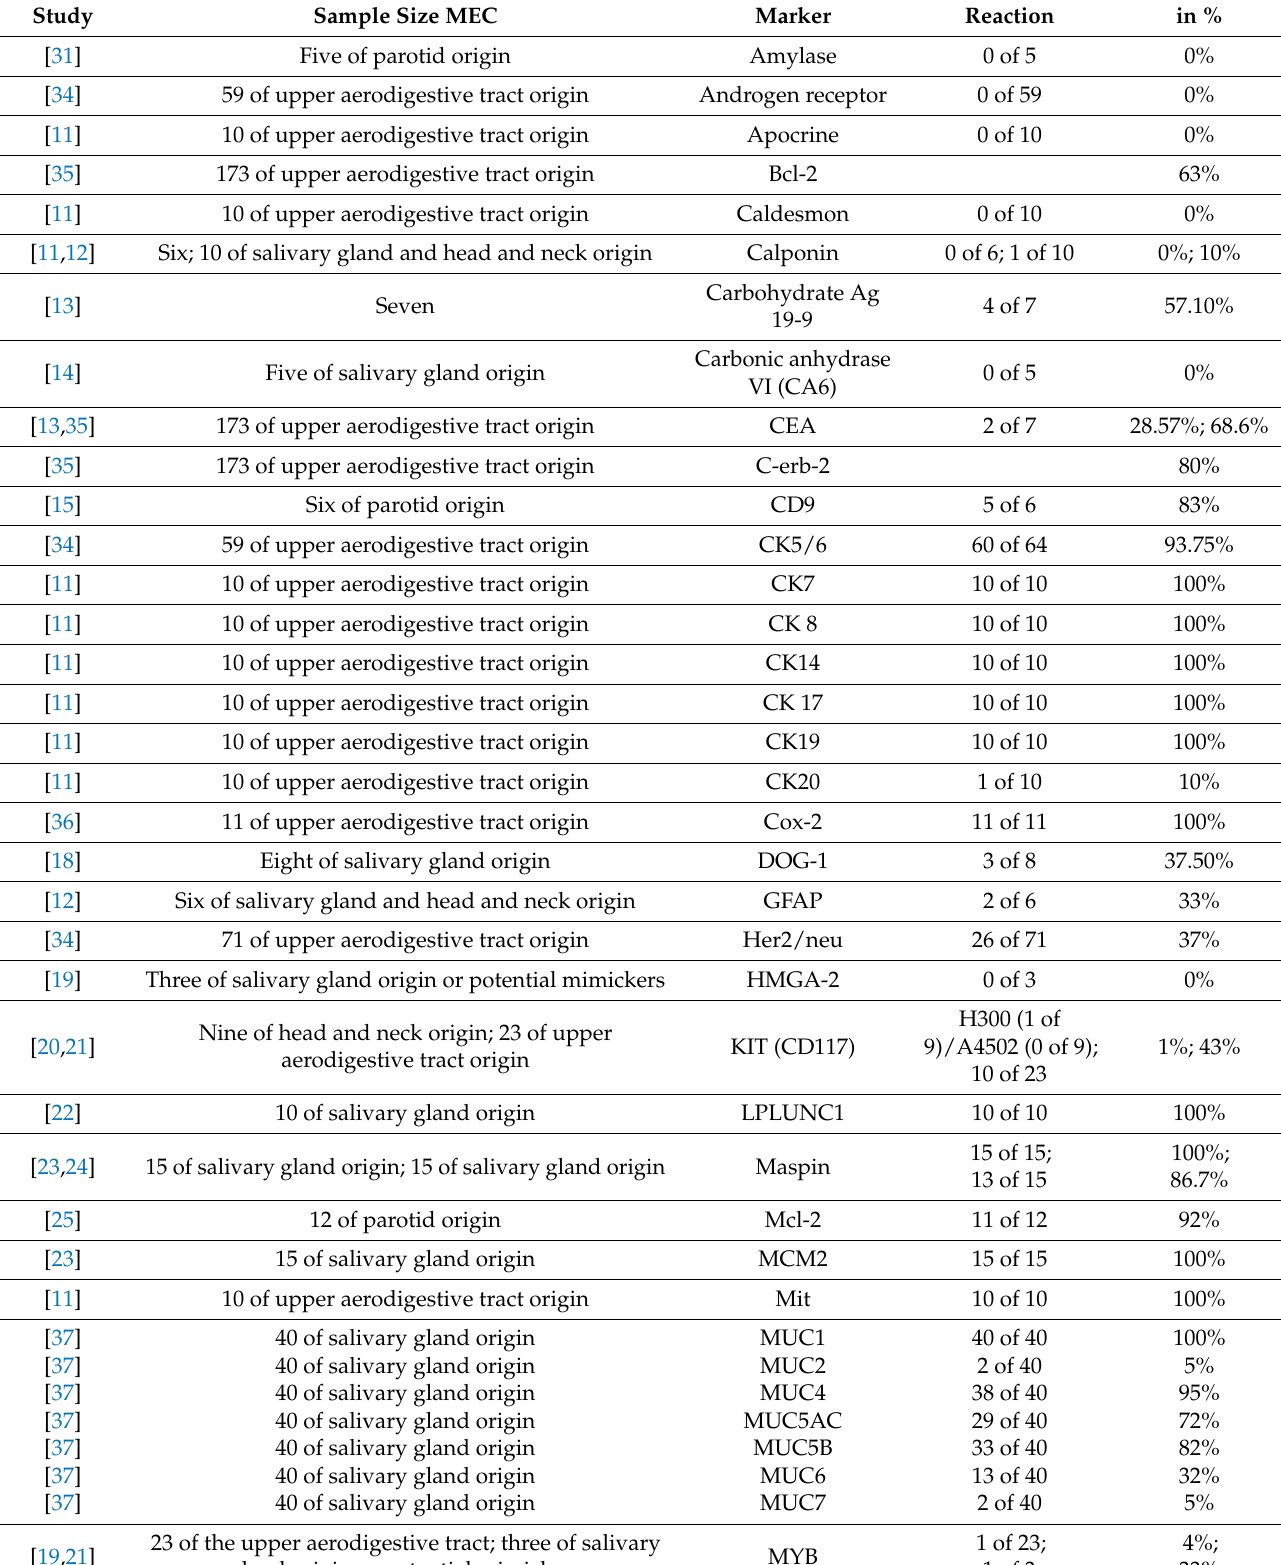
Table 4. Results of patient probes with mucoepidermoid carcinomas to various